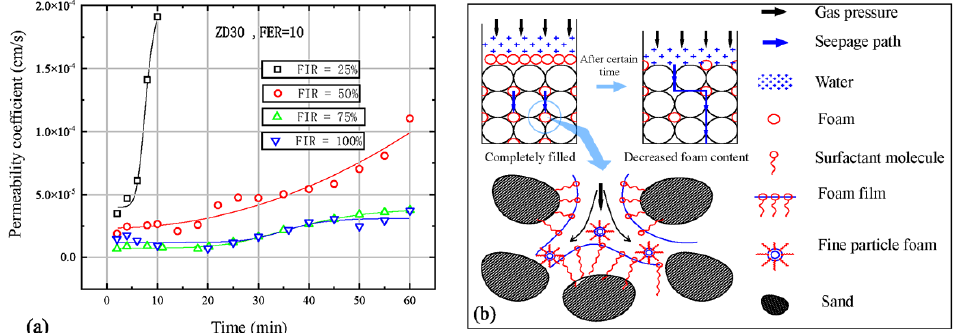
Figure 7. The e ffect of FIR on conditioned sand permeability. ( a ) Conditioned sand permeability coefficient under different FIRs, and ( b ) penetration of foam between sand particles.